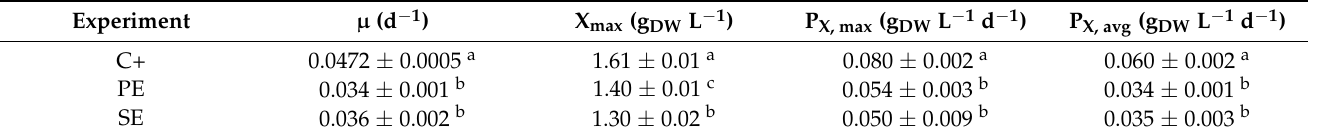
Table 2. Growth parameters determined for Chlorella vulgaris in each